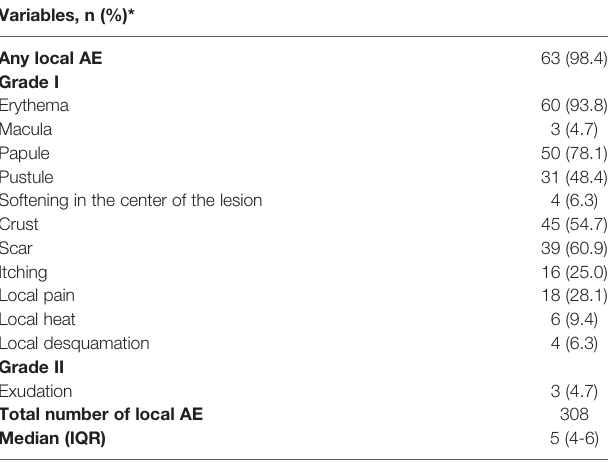
TABLE 5 | Reactogenicity of the BCG vaccine.